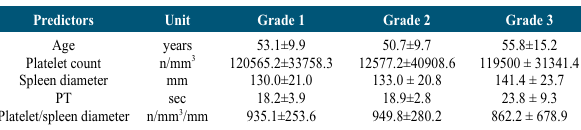
Table 4: Co-relaon between different predictors and severity of